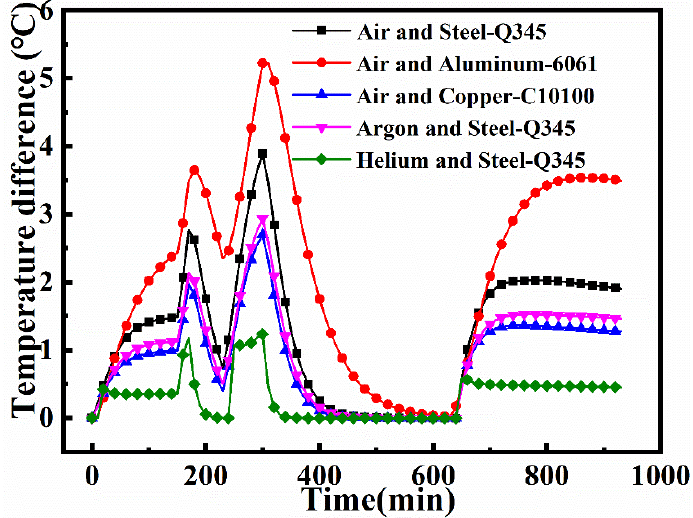
Figure 16. Maximum temperature difference on the mold